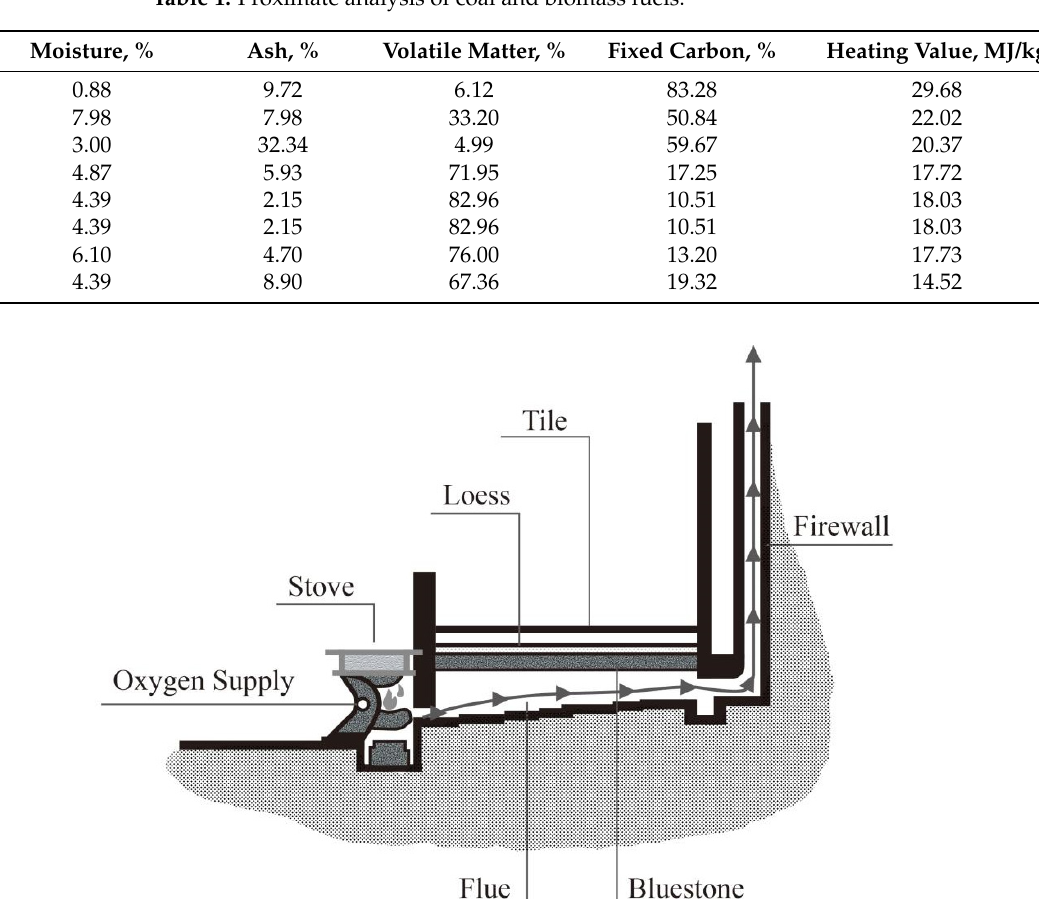
Table 1. Proximate analysis of coal and biomass fuels.